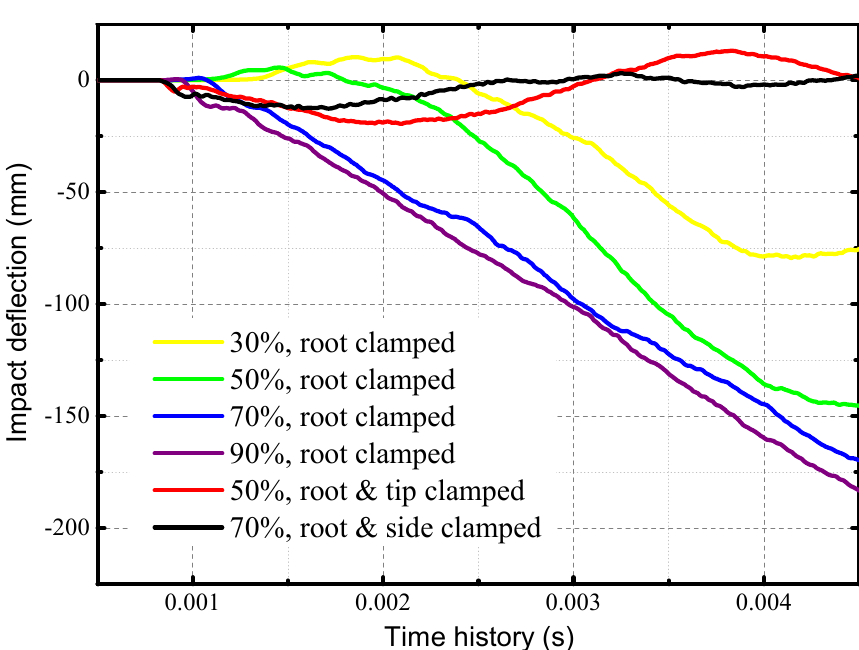
Figure 6. The maximum impact deflections of the six simulated plates with the increasing time.